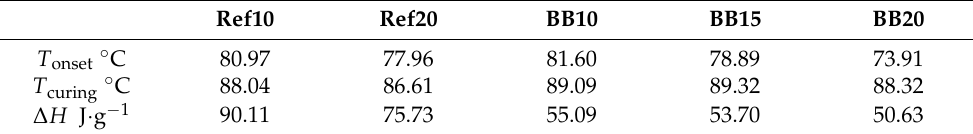
Table 7. DSC results of adhesive compositions used in this